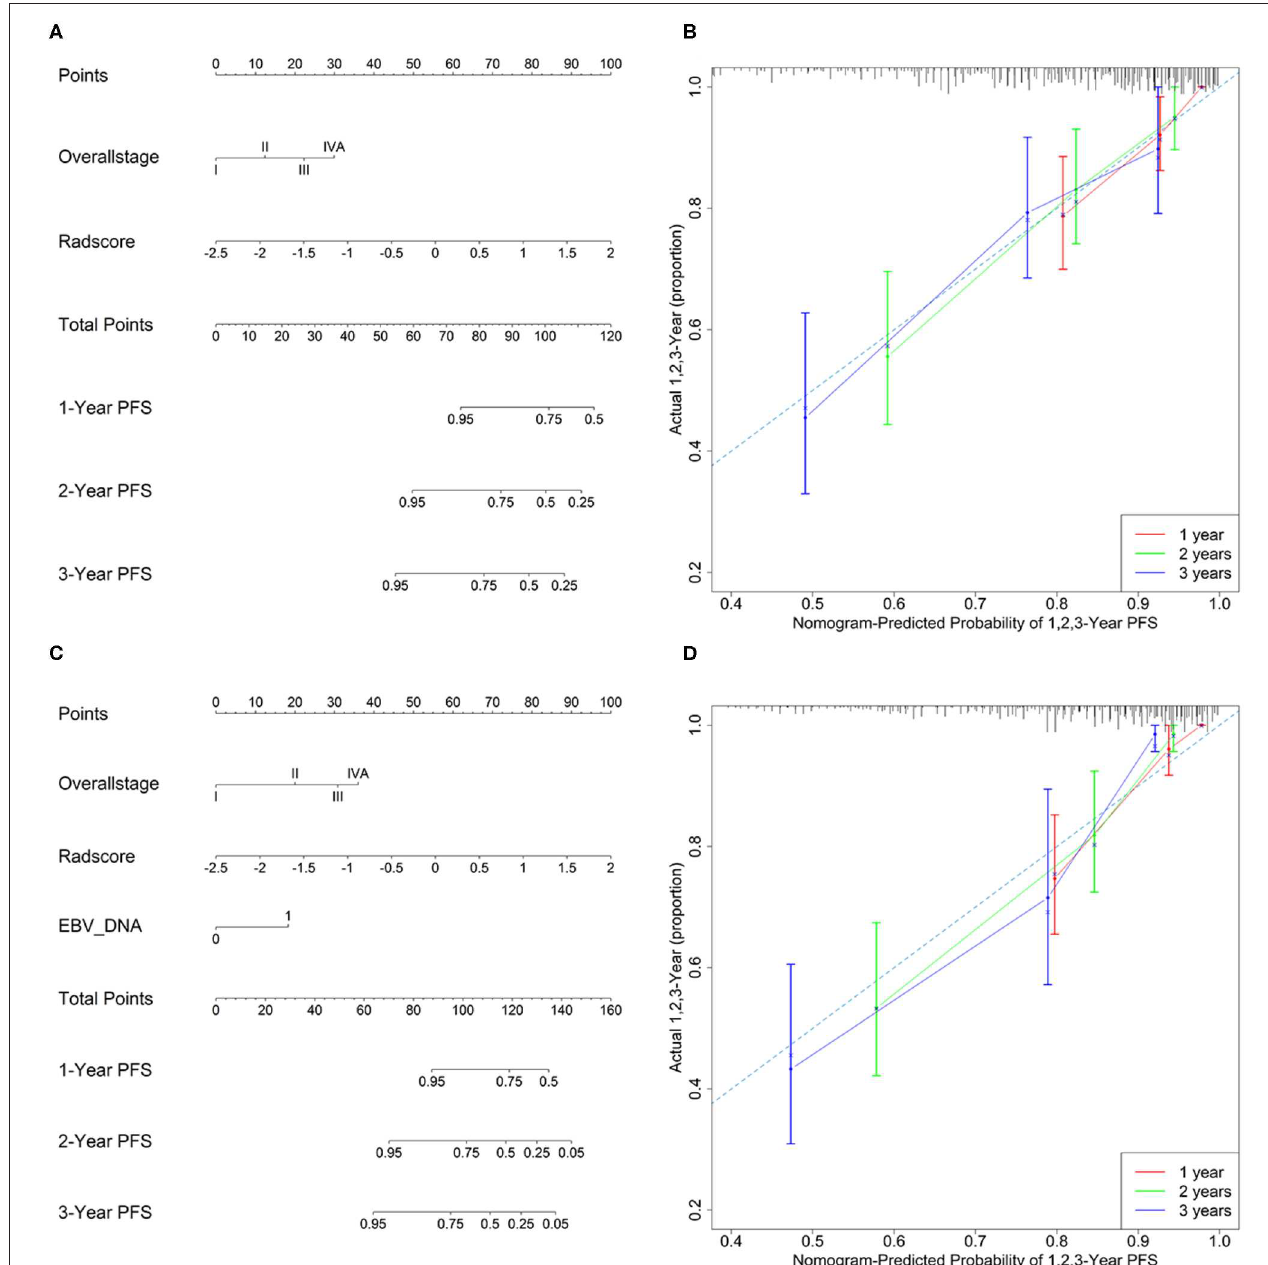
FIGURE 2 | (A) A radiomic nomogram without EBV DNA integrating the radiomic signature with the TNM staging system. (B) Calibration curve of the radiomic nomogram without EBV DNA. (C) A radiomic nomogram with EBV DNA integrating the radiomic signature, TNM staging system, and EBV DNA. (D) Calibration curve of the radiomic nomogram with EBV DNA.